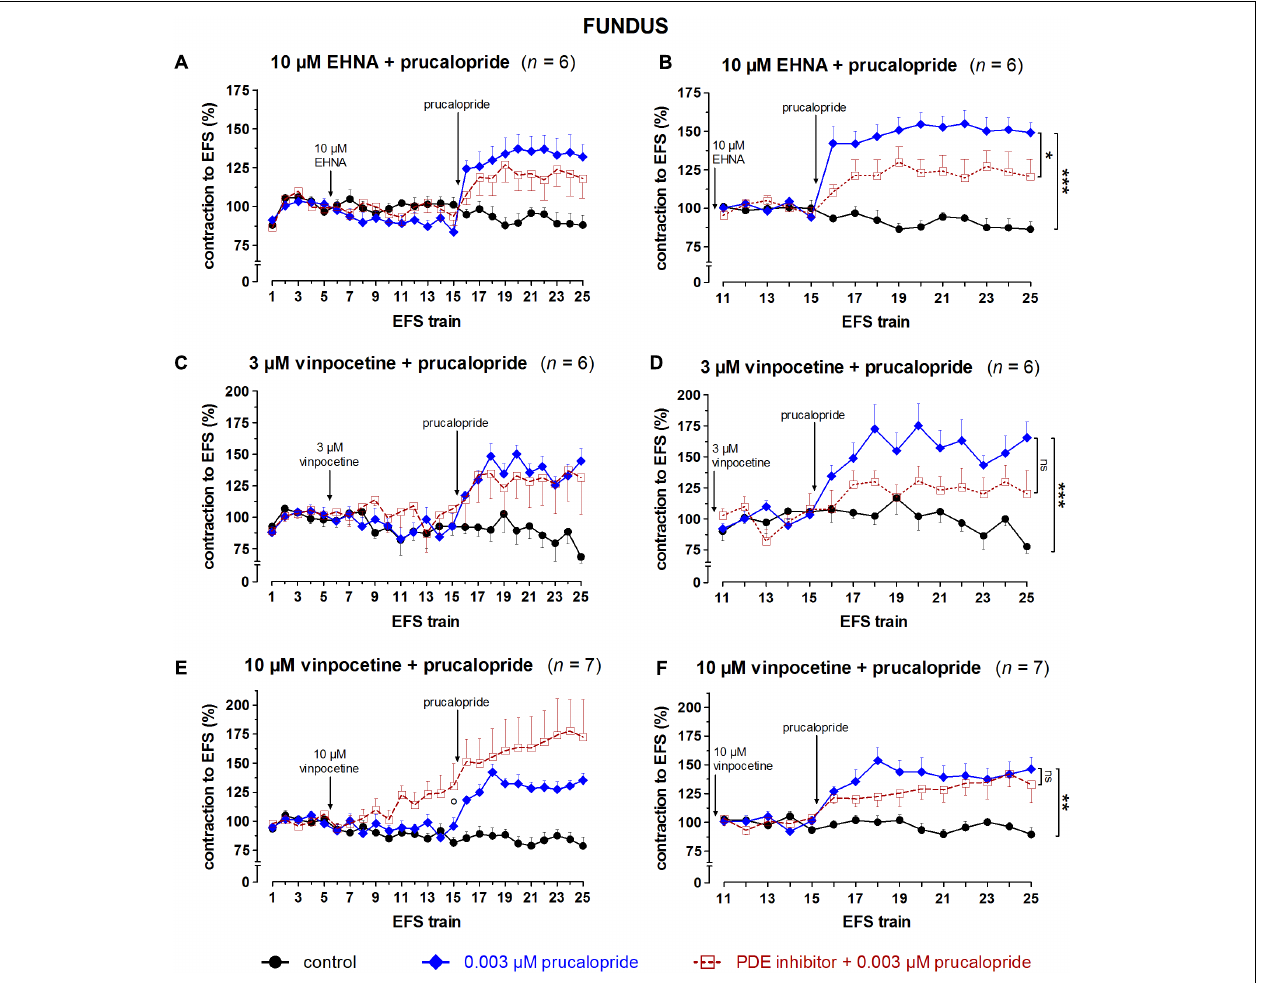
FIGURE 9 | Influence of 10 µ M EHNA (A,B) , 3 (C,D) and 10 (E,F) µ M vinpocetine on the facilitating effect of 0.003 µ M prucalopride on submaximal electrically induced cholinergic contractions at V 50% (10 s trains at 4 Hz, 0.5 ms, interval of 5 min) in murine fundus circular smooth muscle strips. The number of the consecutive stimulation trains is given on the y-axis. Contractions are expressed as percentage of the mean of the five contractions before addition of the PDE inhibitor (trains 1–5; A,C,E ) or of the five contractions in the presence of the PDE inhibitor just before adding prucalopride (trains 11–15; B,D,F ). Experiments were performed in the continuous presence of 4 µ M guanethidine and 300 µ M L-NAME. Means ± SEM. Left panels, last EFS-induced contraction before adding prucalopride: ◦ P < 0.05 versus control (one-way ANOVA with Bonferroni corrected t -test for two comparisons i.e., PDE inhibitor versus control and versus prucalopride). Right panels, last EFS-induced contraction: ns not significant, ∗ P < 0.05, ∗∗ P < 0.01, ∗∗∗ P < 0.001 (one-way ANOVA with Bonferroni corrected t -test for two comparisons i.e., prucalopride versus control and versus prucalopride in the presence of the PDE